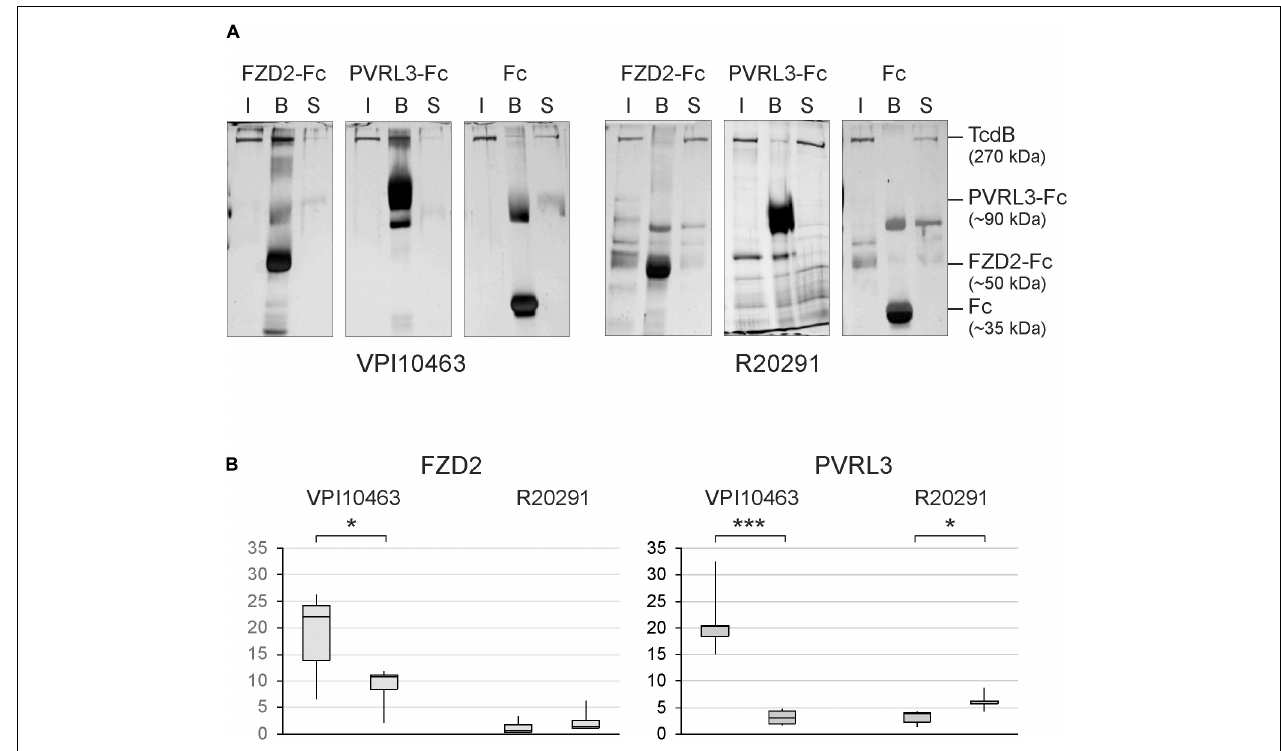
FIGURE 3 | Receptor binding of clade I and II TcdB. (A) Silver-stained SDS gels show binding of TcdB to the immobilized extracellular domains of FZD2 and PVRL3. Shown is the input (I), the fraction bound to Fc-fusion receptors coupled to protein A/G sepharose beads (B) and toxin remaining in the supernatant (S) from pull-down assays. Controls were performed with only Fc coupled to protein A/G sepharose. (B) Densitometrical evaluation of binding of TcdB and TcdB C2232Y from strain VPI10463 as well as TcdB and TcdB Y2232C from strain R20291 to FZD2-Fc and PVRL3-Fc from pull-down assays (means ± SD, n = 6, ∗ , ∗∗∗ p -values < 0.05 and < 0.001,